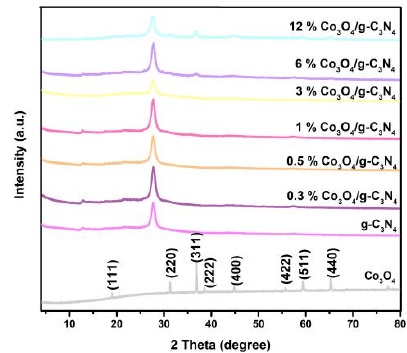
Figure 1. XRD pattern of fabricated samples.